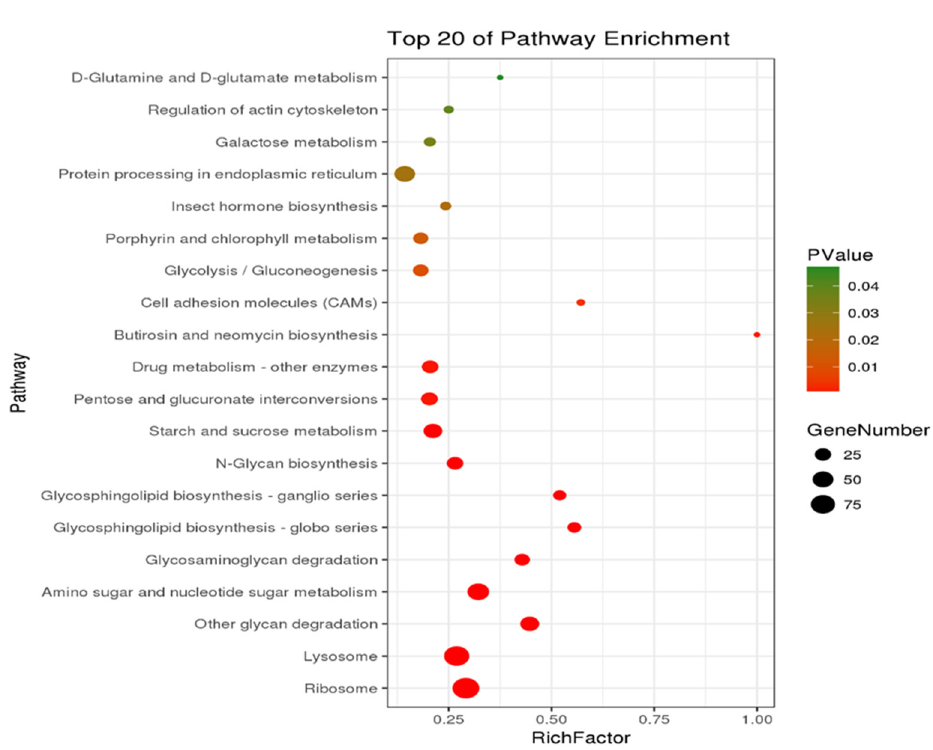
Figure 5. Diagram of CK-vs-PS KEGG enrichment analysis.